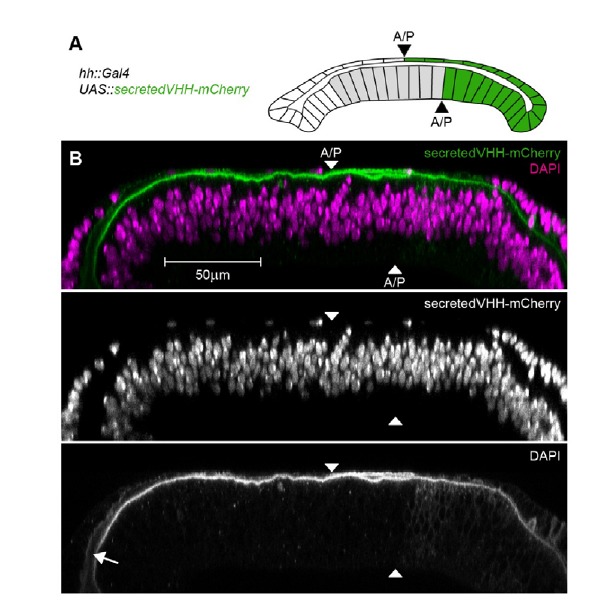
Detection of a secreted VHH-mCherry fusion in the wing disc lumen.(A) Schematic representation of the experimental setup. We expressed a fusion of the mouse CD8 signal peptide, the vhhGFP4 GFP-nanobody and mCherry (secretedVHH-mCherry) under the control of hh::Gal4 in the posterior compartment of otherwise wild type wing discs. Importantly, the anterior/posterior compartment boundary (A/P) in the peripodial epithelium (top layer) is shifted anteriorly compared to the disc proper (bottom layer). However, hh::Gal4 is exclusively active in posterior cells. (B) Optical cross-sections of wing discs expressing secretedVHH-mCherry (green) in the posterior compartment (hh::Gal4). The wing disc shown was permeabilized by several washes with PBST and subsequently stained for DAPI (magenta). Despite the permeabilization, secretedVHH-mCherry was not washed out and can even be detected in the anterior most parts of the lumen (arrow).